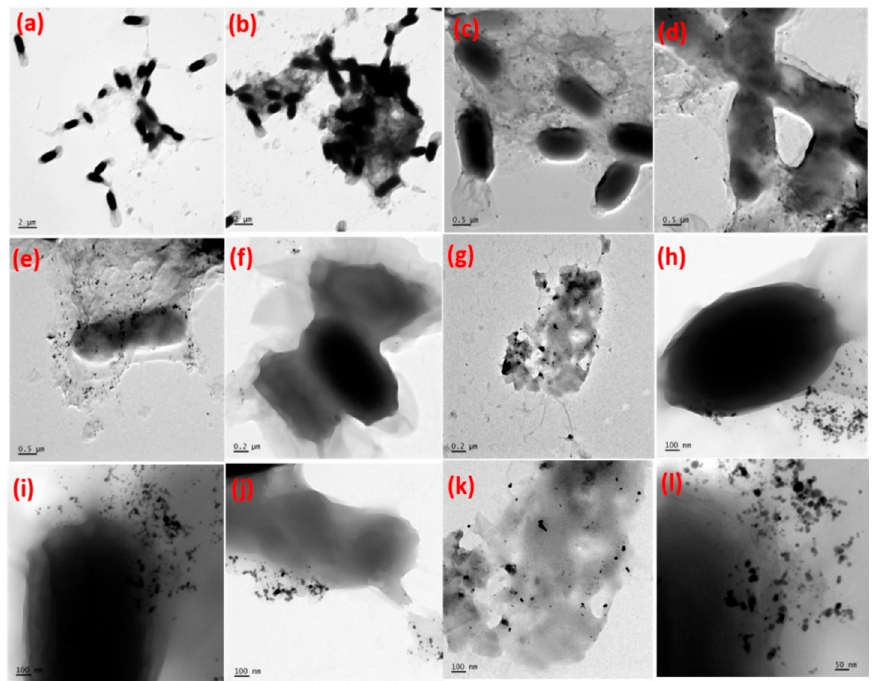
Figure 6. The TEM images of ( a , b ) E. coli bacteria treated with the sample Ag-GO@532 nm synthesized at the ablation time 15 min and ( c – l ) various destruction stages of E. coli bacteria.